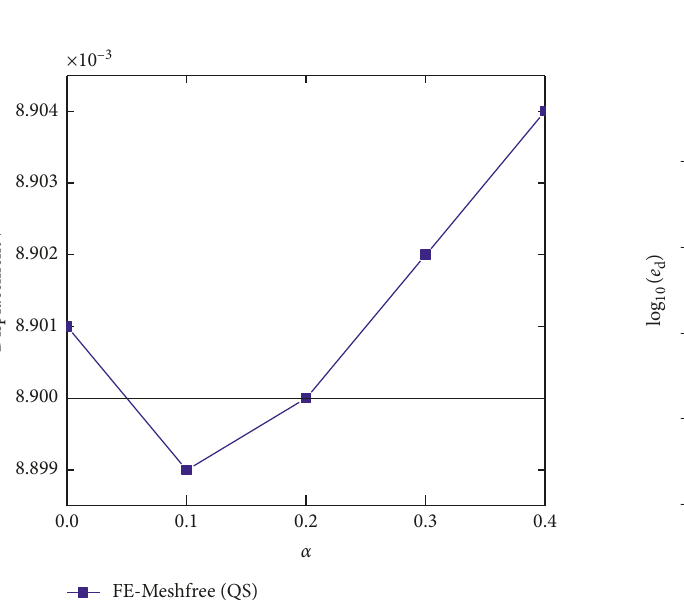
Figure 5: Condition number.